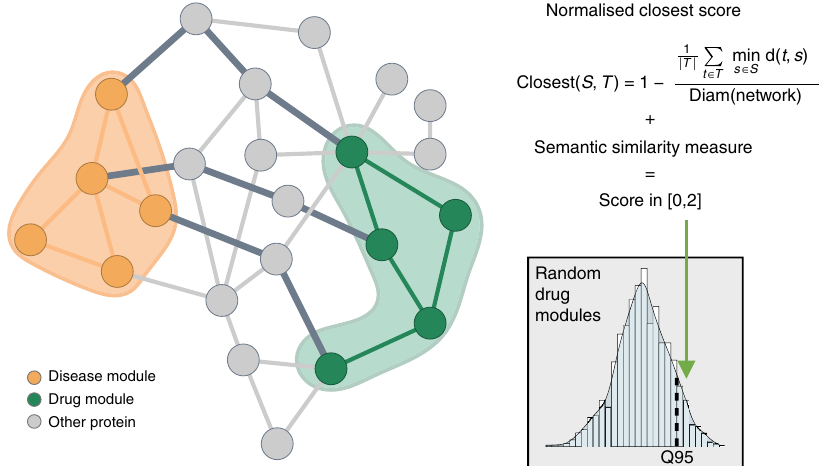
Fig. 5 Illustration of the score calculation to evaluate the drug-disease interplay. The score combines network distances and functional similarity between proteins in the drug module (green nodes) and proteins in the disease module (orange nodes). The network score assesses the shortest path lengths connecting each protein of the drug module to the nearest protein in the disease module (dark gray edges) while the semantic similarity measure evaluates the functional similarity between the modules. To test the score signi fi cance, the distance between drug and disease modules is compared to a reference distribution of scores computed with drug modules randomly chosen from the